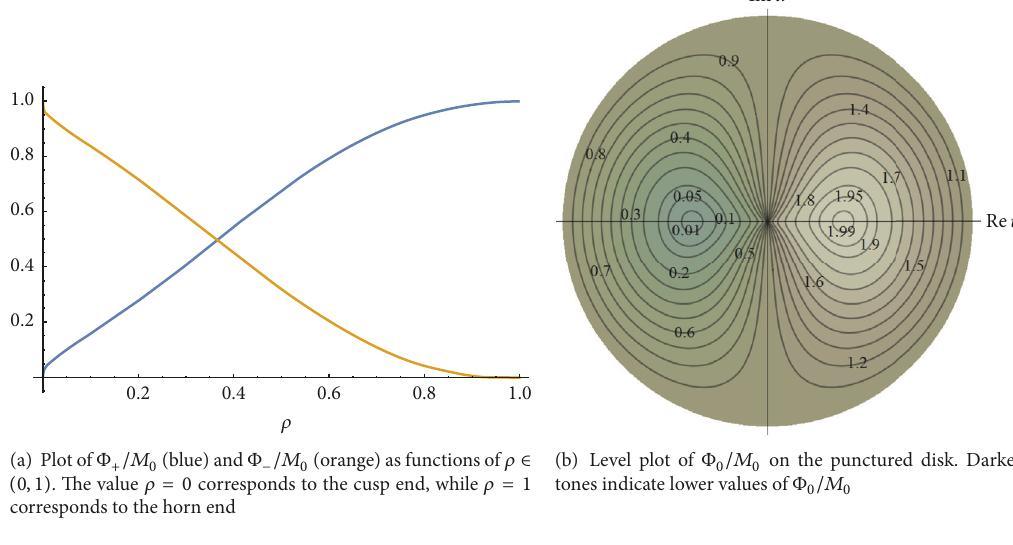
Figure 5: The potentials Φ ± and Φ 0 on the hyperbolic punctured